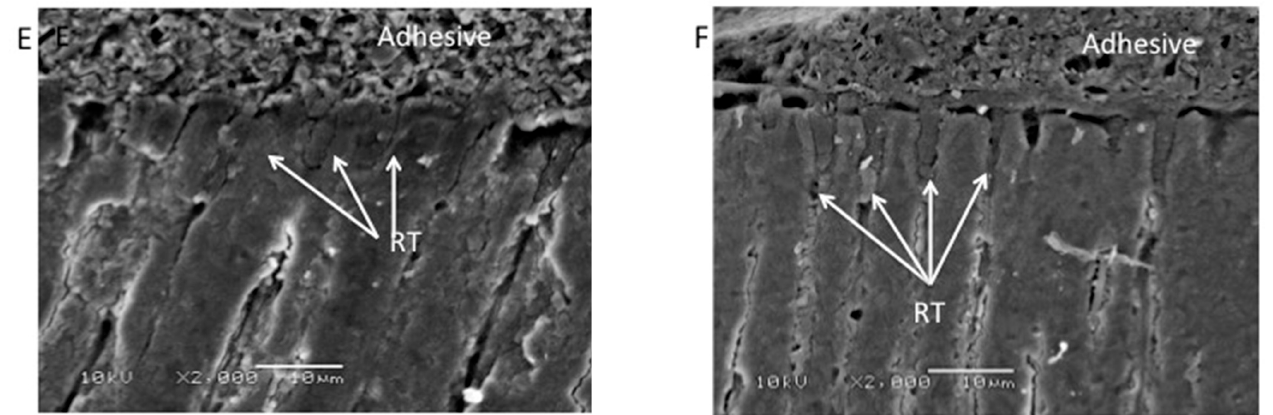
Figure 3. SEM images of bonded dentin specimen. ( A ) HA-PDT group specimens showing standard hybrid layer (HL) formation with low to average resin tag formation in dentin. ( B ) HA-ER group specimens showing classic HL formation with a high number of resin tags. ( C ) HA-ECY group specimens showing uneven dentin surface and craters (arrows) at the interface with no resin tags and dentin penetration. ( D ) EA-ECY group specimens displaying craters (arrows) on the dentin surface at the interface with little to no HL and missing resin tags, showing minimal dentin penetration. ( E ) EA-PDT group specimens showing a low number of resin tags in dentin. ( F ) EA-ER group specimens showing standard HL and multiple resin tag formation.